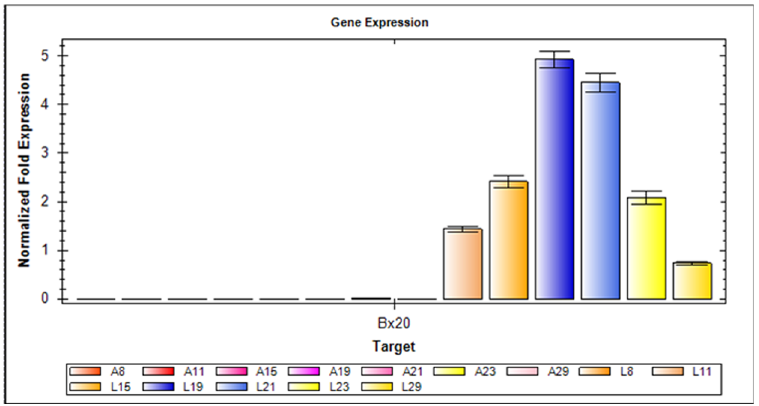
Fig 4. Expression profile of the 1Bx20 gene at different development stages in LX987 and AS208 assessed by qRT-PCR. The 1Bx20 gene was not expressed at any stages during grain development in AS208 (A8-A29). Its expression in LX987 started from the 11 th day since anthesis (L11), reached its highest level at the 19 th day post anthesis, and then gradually declined as filling progressed (L21-L29).